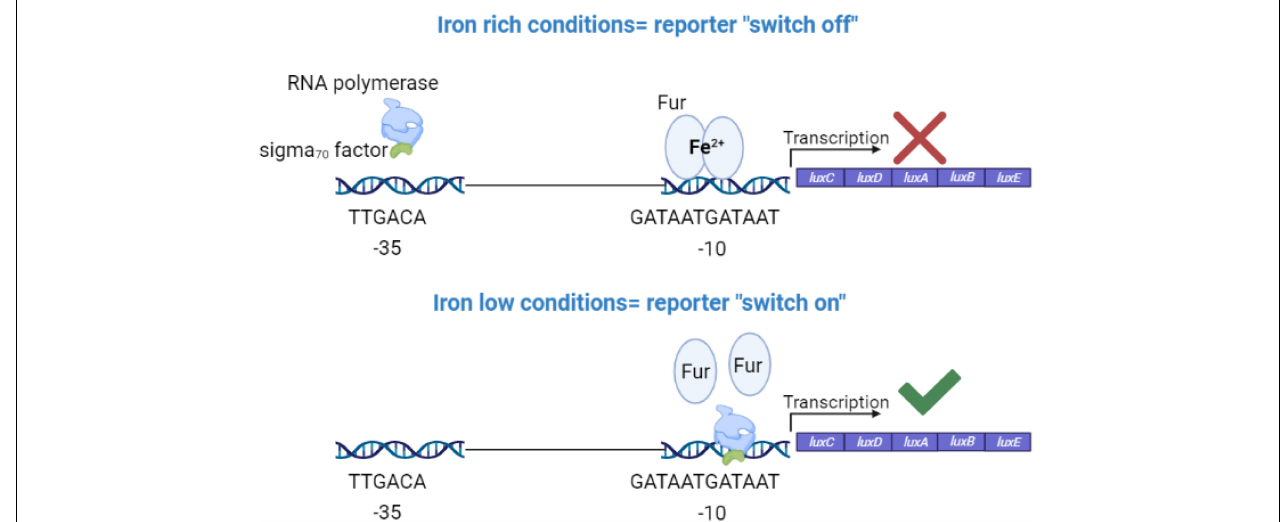
FIGURE 7 | Molecular design for the iron sensing promoter region. TTGACA sequence is recognized by sigma 70 factor which directs the RNA polymerase to the promoter region. GATAATGATAAT is the consensus sequence recognized by ferric uptake regulator protein (Fur) and known as the fur box. In Salmonella , ferrous iron together with Fur, form a dimer and bind to fur box like sequences upstream of iron regulated genes to block the transcription under iron sufficient